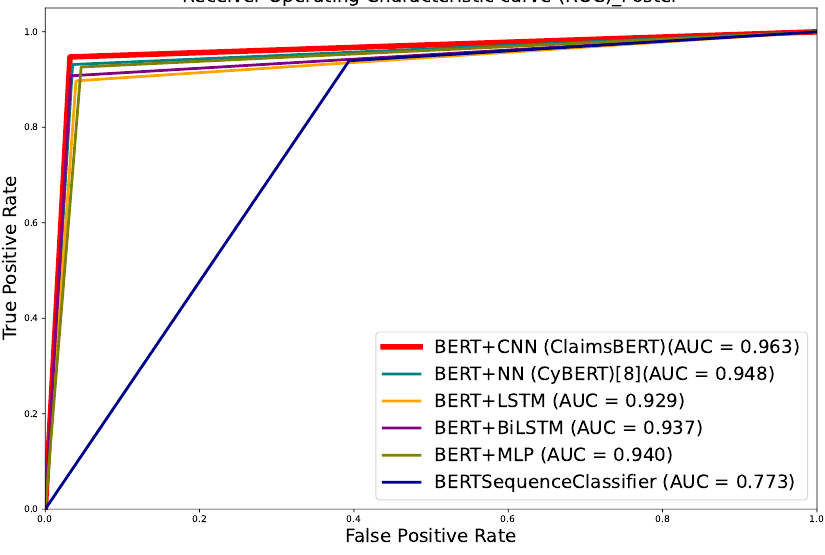
Figure 12. ROC comparison for all language